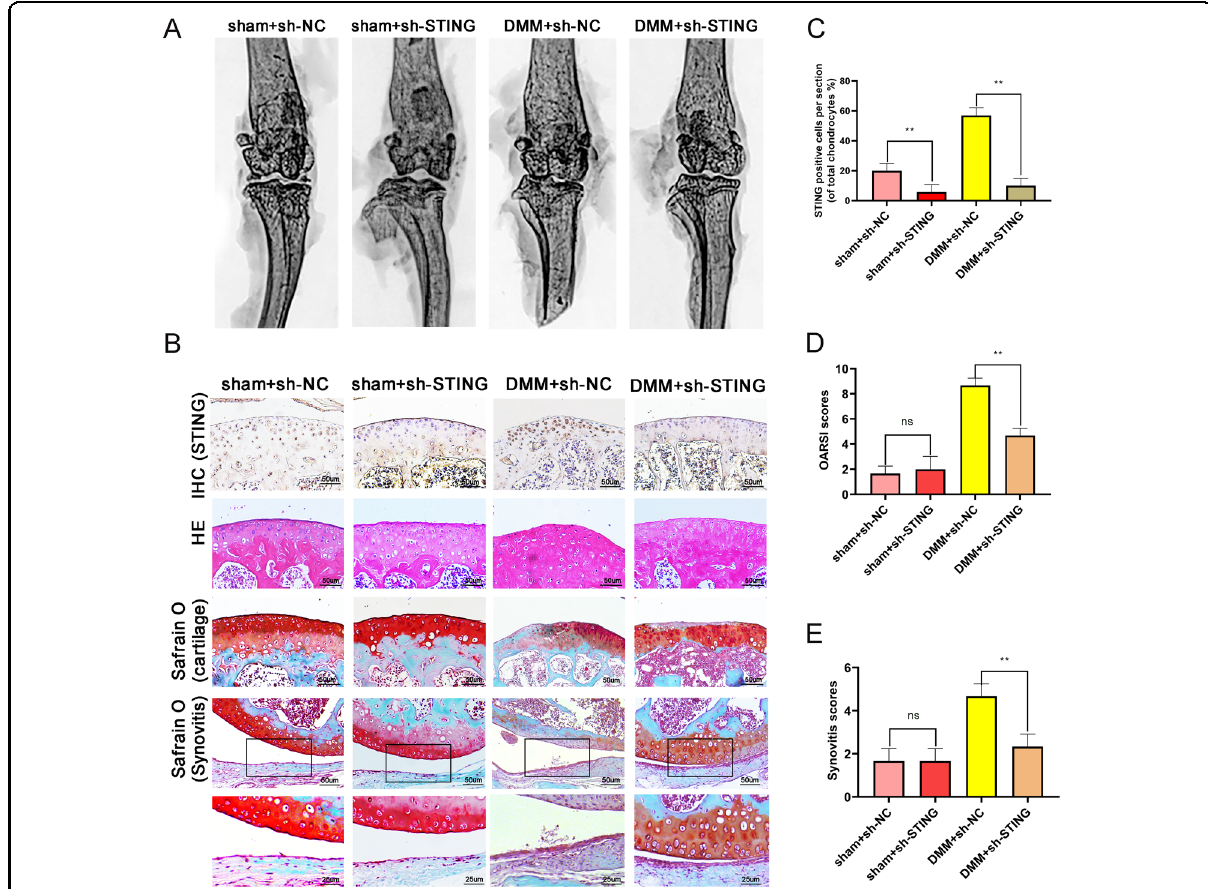
Fig. 6 STING knockdown ameliorates osteoarthritis in vivo. The osteoarthritis mouse model was created by surgical destabilization of the medial meniscus (DMM), after 8-week time period, the pathology of OA was assessed by X-ray or stained with H&E, as well as Safranin O. A Digital X-ray image of mouse knee joints from different experimental groups. B Representative immunohistochemistry of STING, S-O staining of the cartilage and synovitis in the four groups at eight weeks post-surgery (bar: 50 or 25 μ m). C Quantitative analysis of immunohistochemistry of STING was detected by image J. D – E The OARIS scores of the cartilage and the scores of the synovitis in the four groups. All data were presented as mean ± SD ( n = 15), ** P <